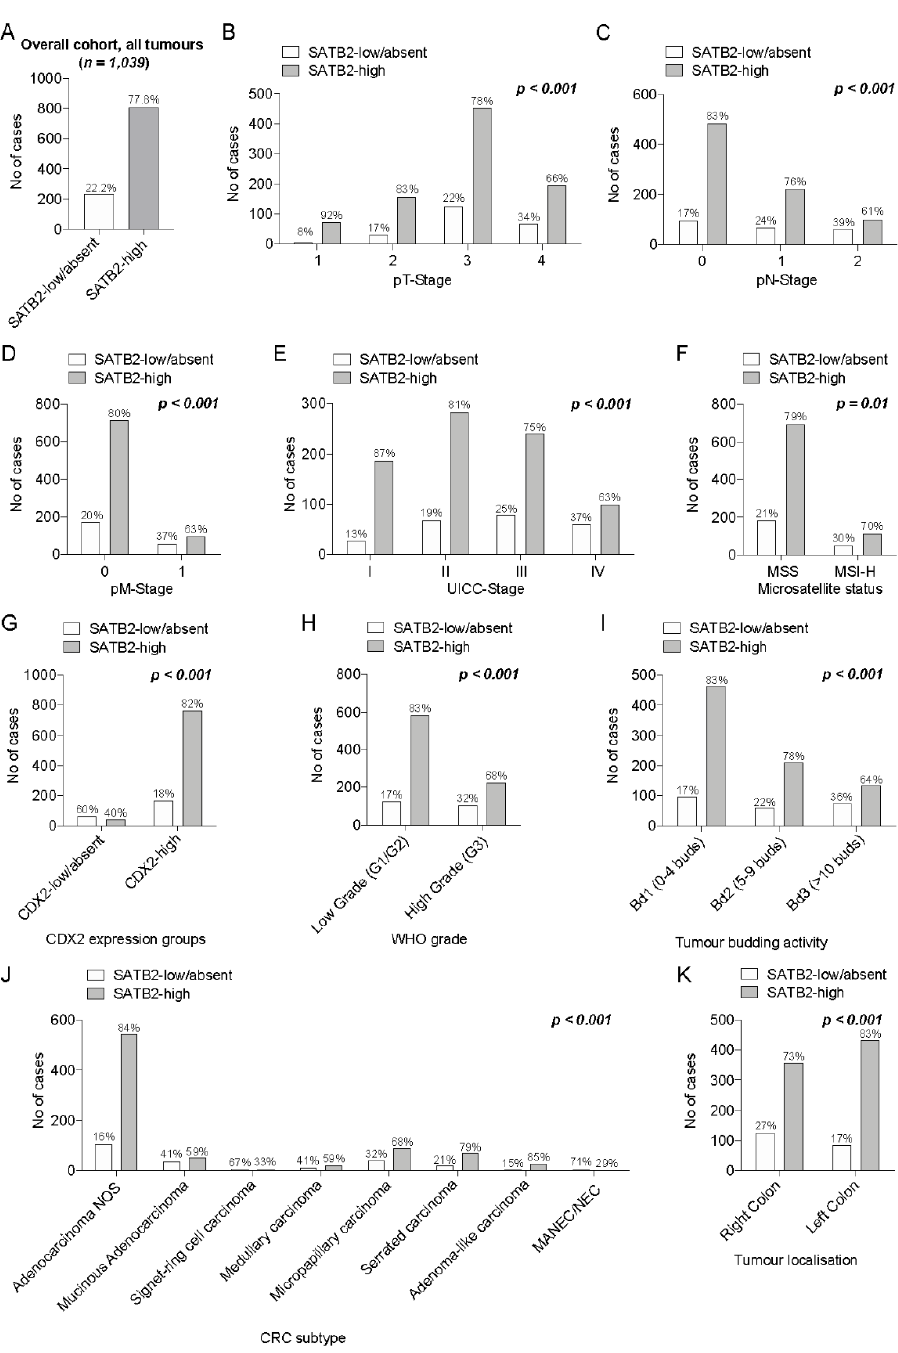
Figure 2. ( A – D ): Prevalence of SATB2 expression groups within the overall cohort ( A ) and in pT ( B ), pN ( C ), pM ( D ) and combined UICC stage subgroups ( E ). ( F , G ): Distribution of SATB2 expression groups among MSS vs. MSI-H ( F ) and CDX2-low/absent vs. CDX2-high CRCs ( G ). ( H – K ): Differential distribution of SATB2 within WHO low-grade vs. WHO high-grade CRCs ( H ), among the different tumour budding subgroups (Bd1, Bd2, Bd3; ( I )), among colorectal cancer subtypes ( J ) and in right- vs. left-sided CRCs ( K ).